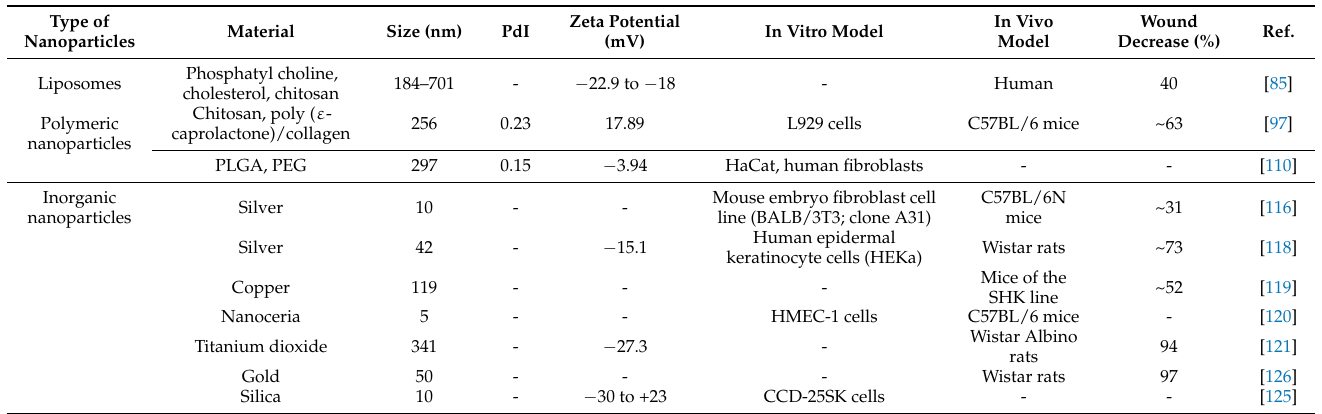
Table 2. Brief summary of nanoparticles encapsulating insulin used for wound healing applications. Type of